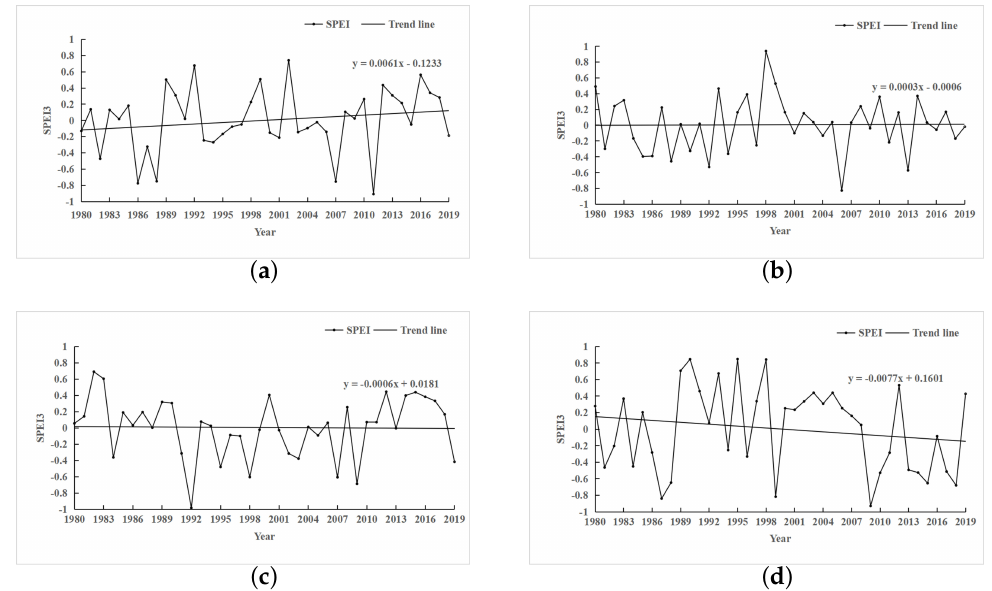
Figure 8. Variation of seasonal SPEI values in the Yangtze River Basin from 1980 to 2019. ( a ) Spring; ( b ) summer; ( c ) autumn; and ( d )